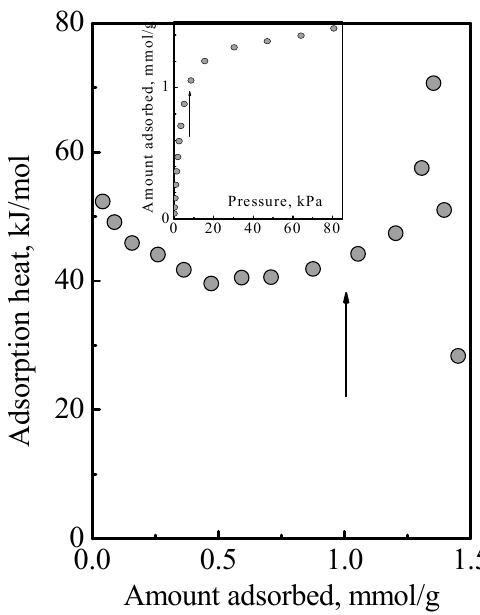
Figure 4. Heat of adsorption as a function of total surface concentration of a 57:43 mol% DME-ethene gas mixture at 25 °C. The inset shows the corresponding total adsorption isotherm. The arrows indicate the acid site density, which is 1 mmol/g.